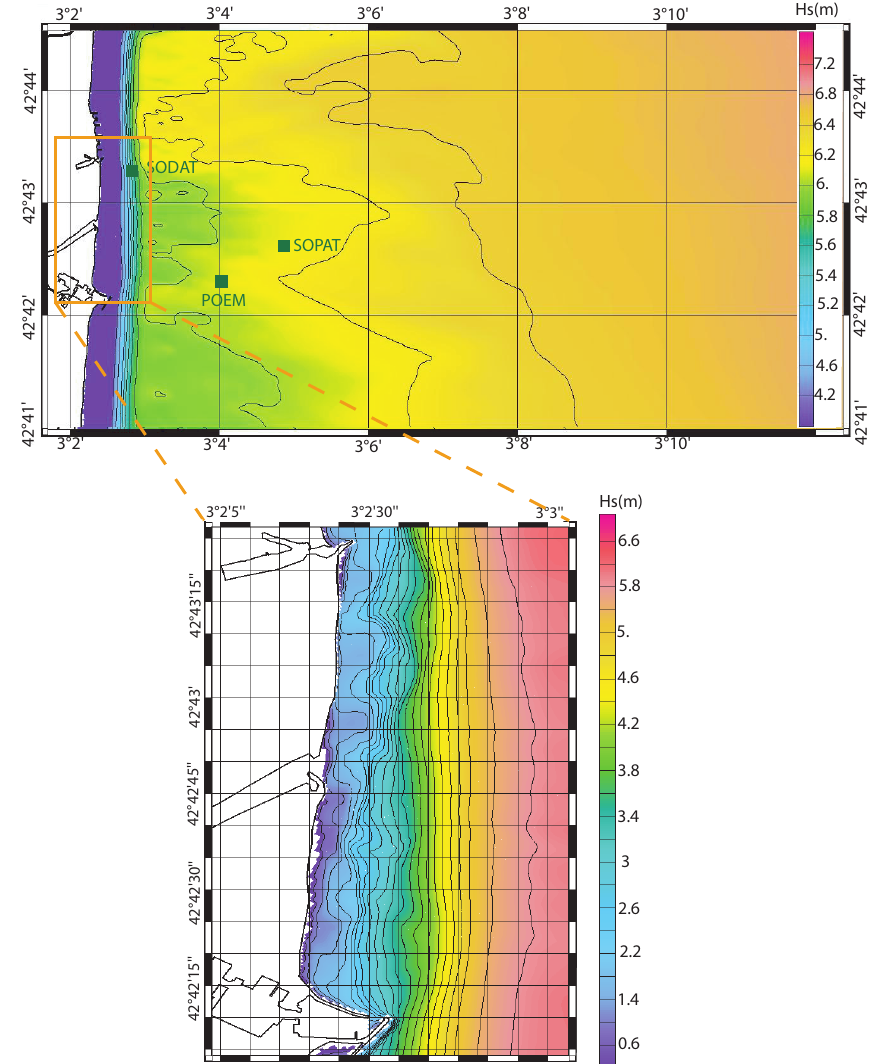
Fig. 14. Significant wave height at the storm apex on 21 February 2004 at 04:19 a.m.